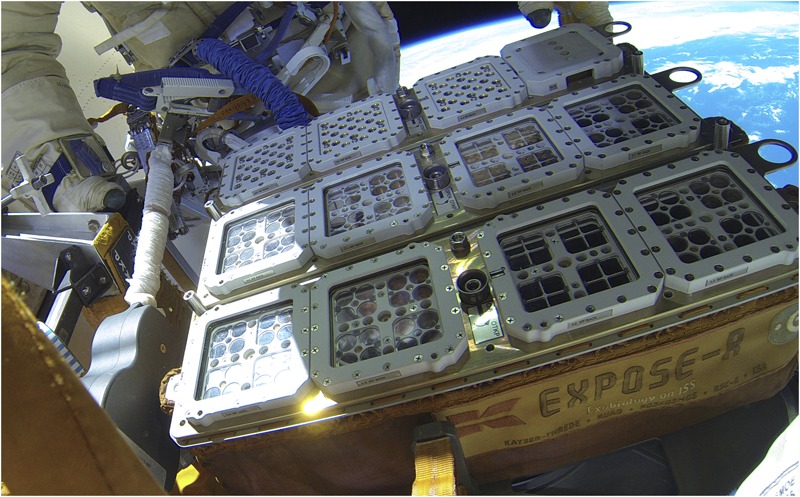
EXPOSE-R2 uncovered in space. The EXPOSE-R monoblock was reused but refurbished with three new trays carrying the samples of the EXPOSE-R2 mission. Credit ESA, ROSCOSMOS.